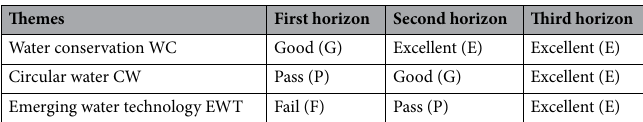
Table 7. Emerging water technology matrix in the